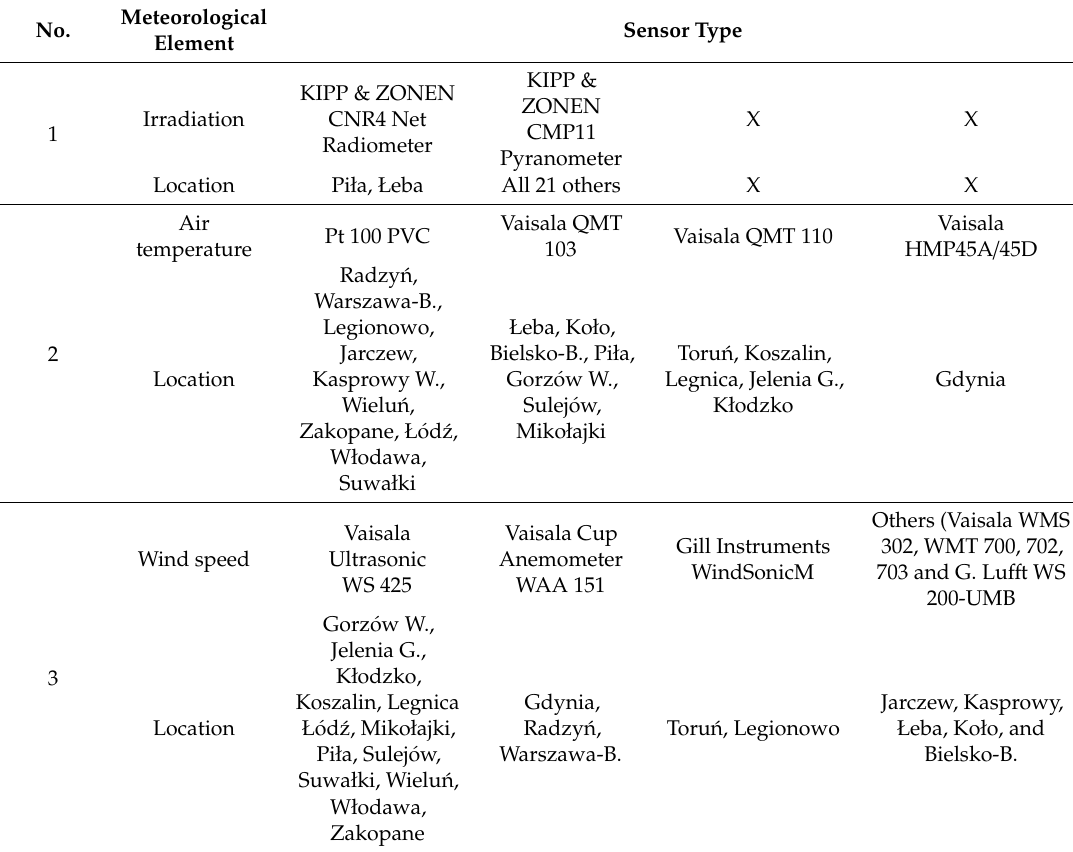
Table 1. Meteorological stations measurement sensor